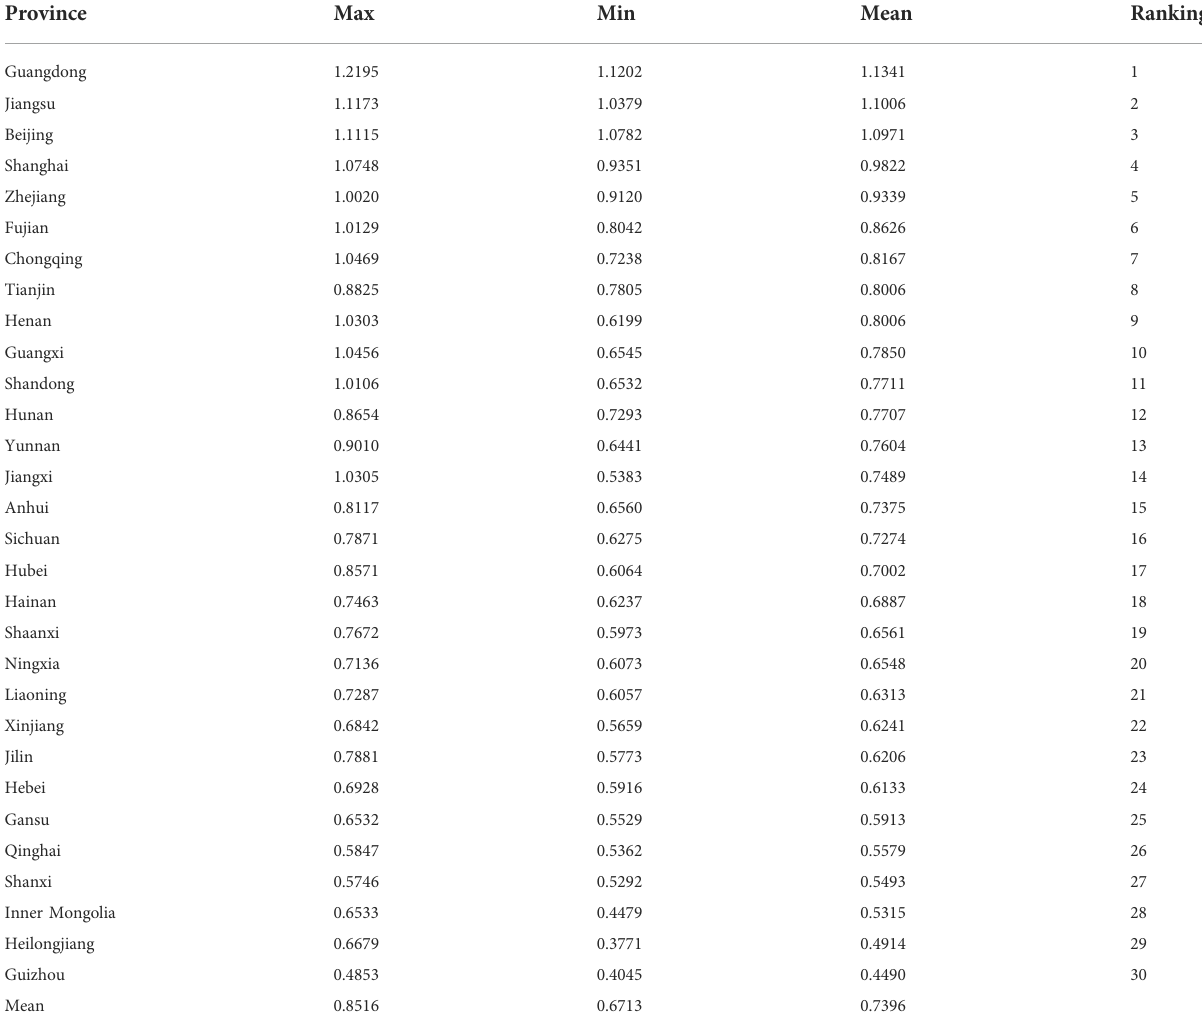
TABLE 4 Estimation results of PBCEE in China.